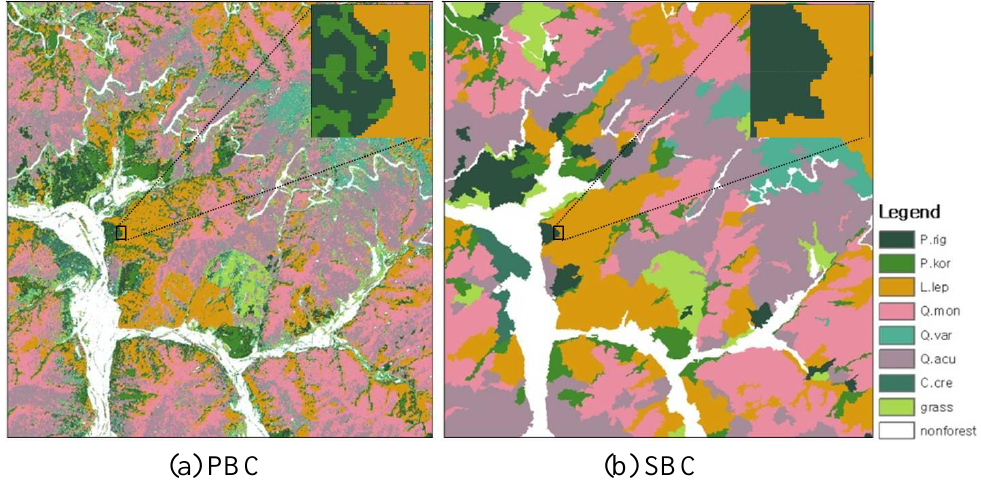
Figure 5. Forest cover map: (a) forest cover map of the pixel-based classification (PBC) using the maximum likelihood method, and (b) segment-based classification (SBC) with majority principle (color parameter of 0.5, scale parameter of